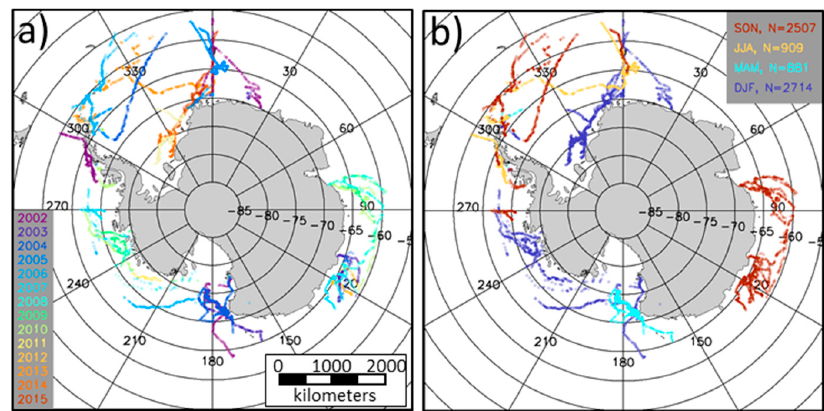
Figure 1. The spatial distribution of the extended ASPeCt data set ( a ) split over years, and ( b ) split over seasons: JJA, SON, DJF, and MAM denote June / July / August, September / October / November, December / January / February, and March / April / May, respectively, i.e., winter, spring, summer, and fall. N denotes the number of observations per